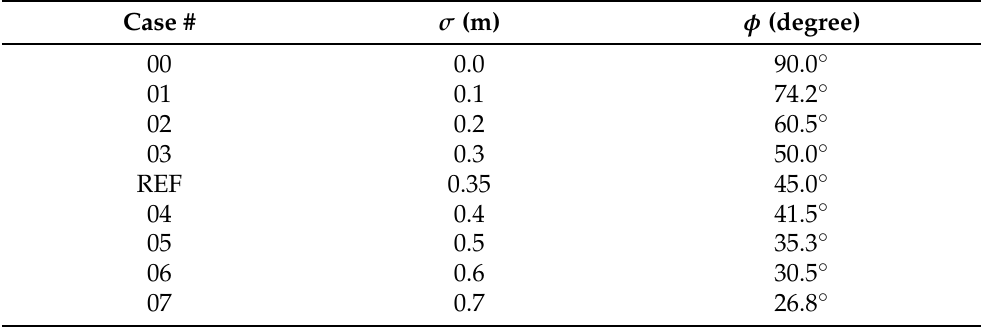
Table 1. Values of slide shape parameter σ and slide front angle φ for all triangular prism shaped model solid slides. Case REF represents the subaerial slide used in the physical modeling by Hein- rich [51]. All slides have the same volume ( V s ), slide length ( L s ), and maximum slide thickness ( S s